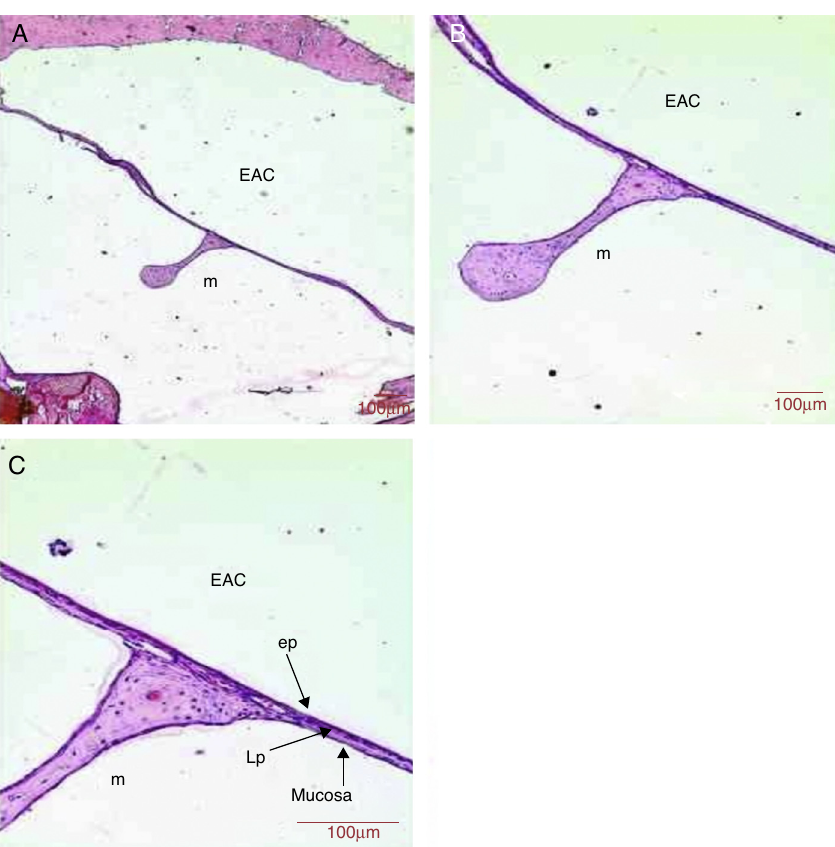
Figure 7 Histological section images of rat TM 14 days after traumatic perforation, stained with HE. EAC, external auditory canal; m, malleus handle; ep, epithelial layer; LP, lamina propria; mucosa, mucosal layer. Image (A) shows a magnification of 40 × ; (B) 100 × and (C) 200 ×